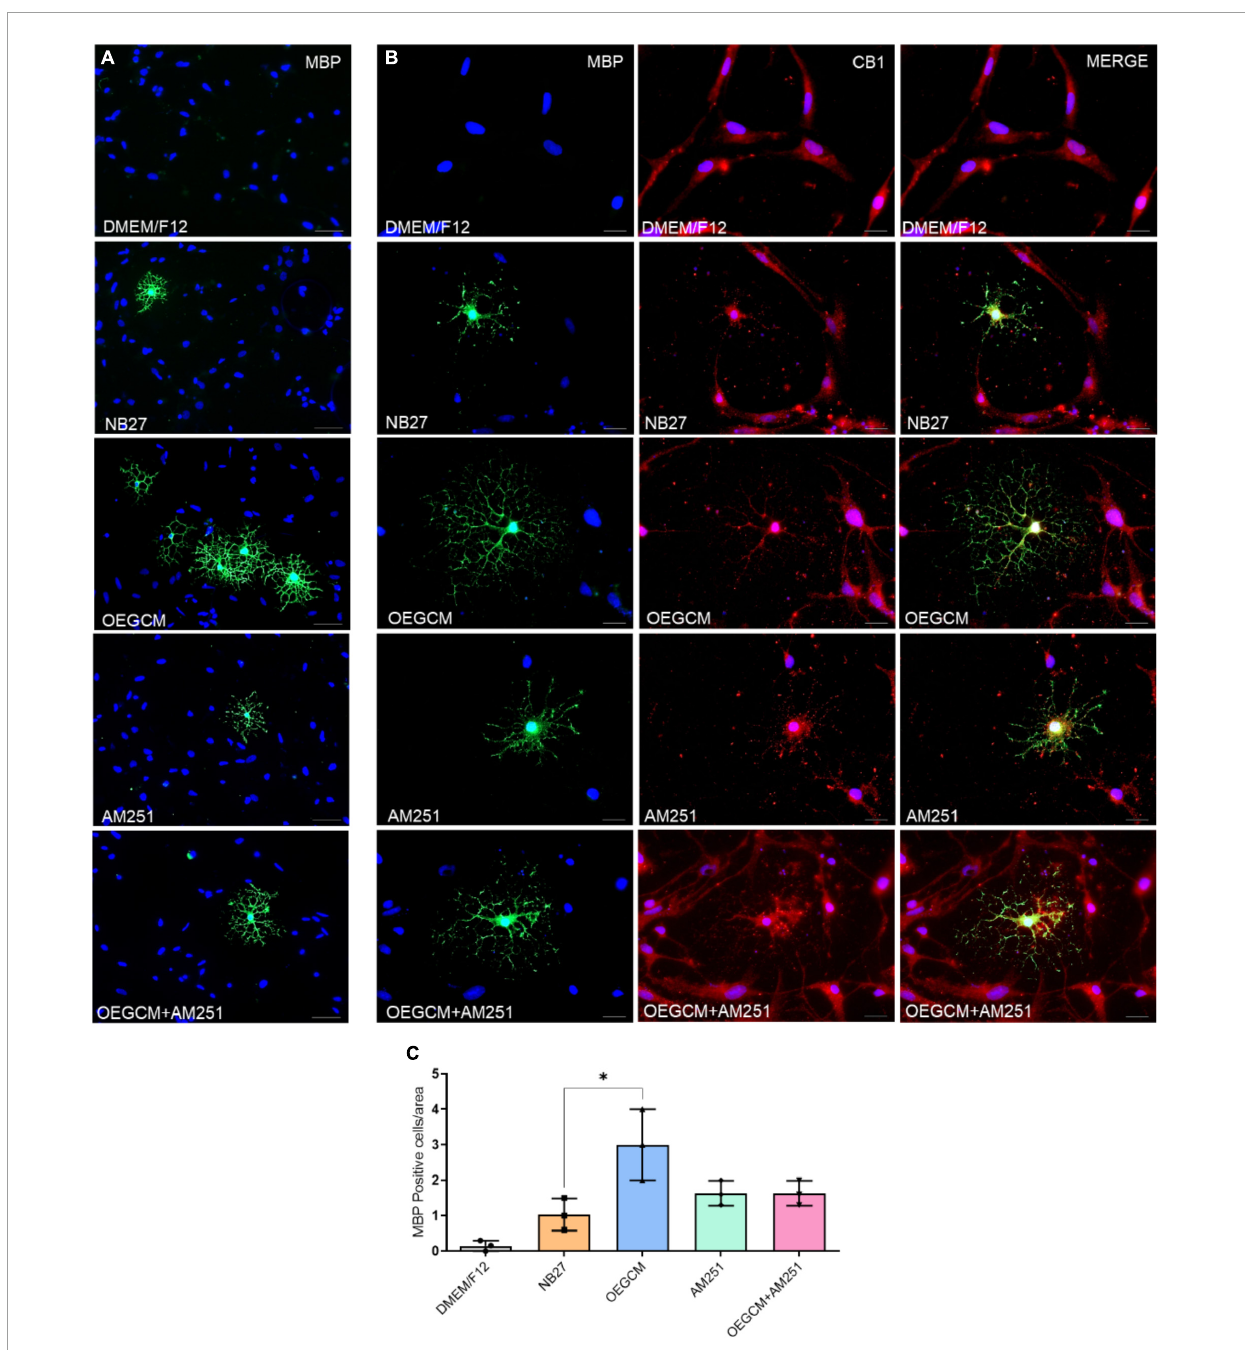
FIGURE6 The blockade of CB1 receptor tends to drive a decrease in MBP expression in oligodendrocytes in hippocampal cells in culture. In panel (A) , MBP positive cells are shown in green and in blue, the cell nuclei (DAPI). Magnification of 20x, scale bar: 50 µ m. N = 3. In panel (B) , immunocytochemistry for MBP in green, CB1 in red and cell nuclei in blue (DAPI). Magnification of 20x, scale bar: 50 µ m. N = 3. In panel (C) , the number of oligodendrocytes in hippocampal cell culture was evaluated counting the number of MBP-positive cells in each condition (for each experiment, 5 images from different areas for each condition was used for the quantification). Data is presented as mean ± SD, statistical analysis was performed using Kruskal-Wallis and Dunn’s as post hoc test. N = 3 for all experimental conditions, p = 0.0301 for NB27 vs. OEGCM, p > 0.9999 for NB27 vs. AM251, p = 0.6842 for OEGCM vs. OEGCM + AM251, p > 0.9999 for AM251 vs. OEGCM + AM251, p = 0.6842 for OEGCM vs. AM251. * p < 0.05.